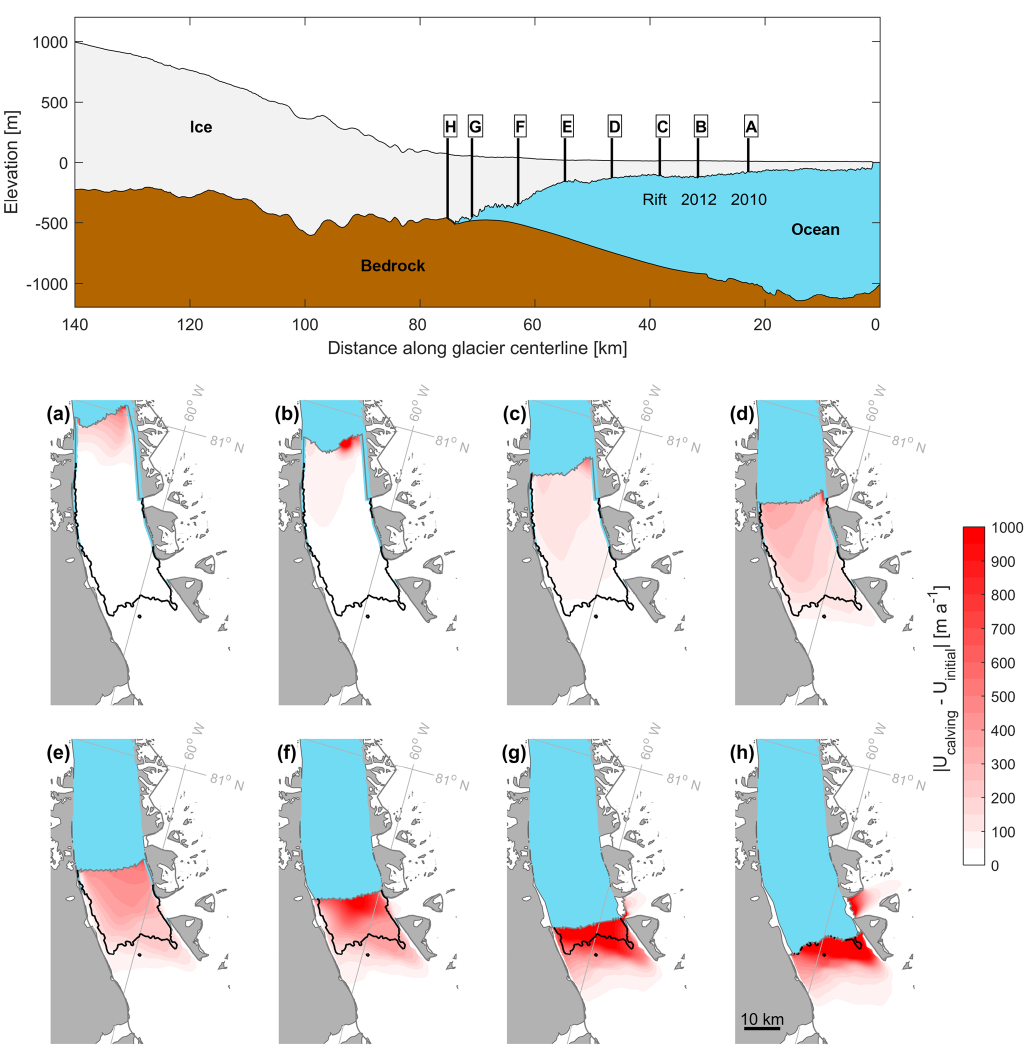
Figure 6. Diagnostic perturbation experiments at Petermann Glacier. The top panel shows a cross-sectional centerline profile of Petermann Glacier from the BedMachine v3 dataset (Morlighem et al., 2017). Letters A to H represent the points along the glacier centerline at which sections of the terminus were removed for each experiment. A is the 2010 calving event, B is the 2012 calving event, and C is the location of a large rift that formed in 2016. D to G are successive 8km splices and H is the current grounding line location. Panels (a) – (h) show the modeled instantaneous increase in speed after each experiment with respect to initial pre-calving (before 2010)